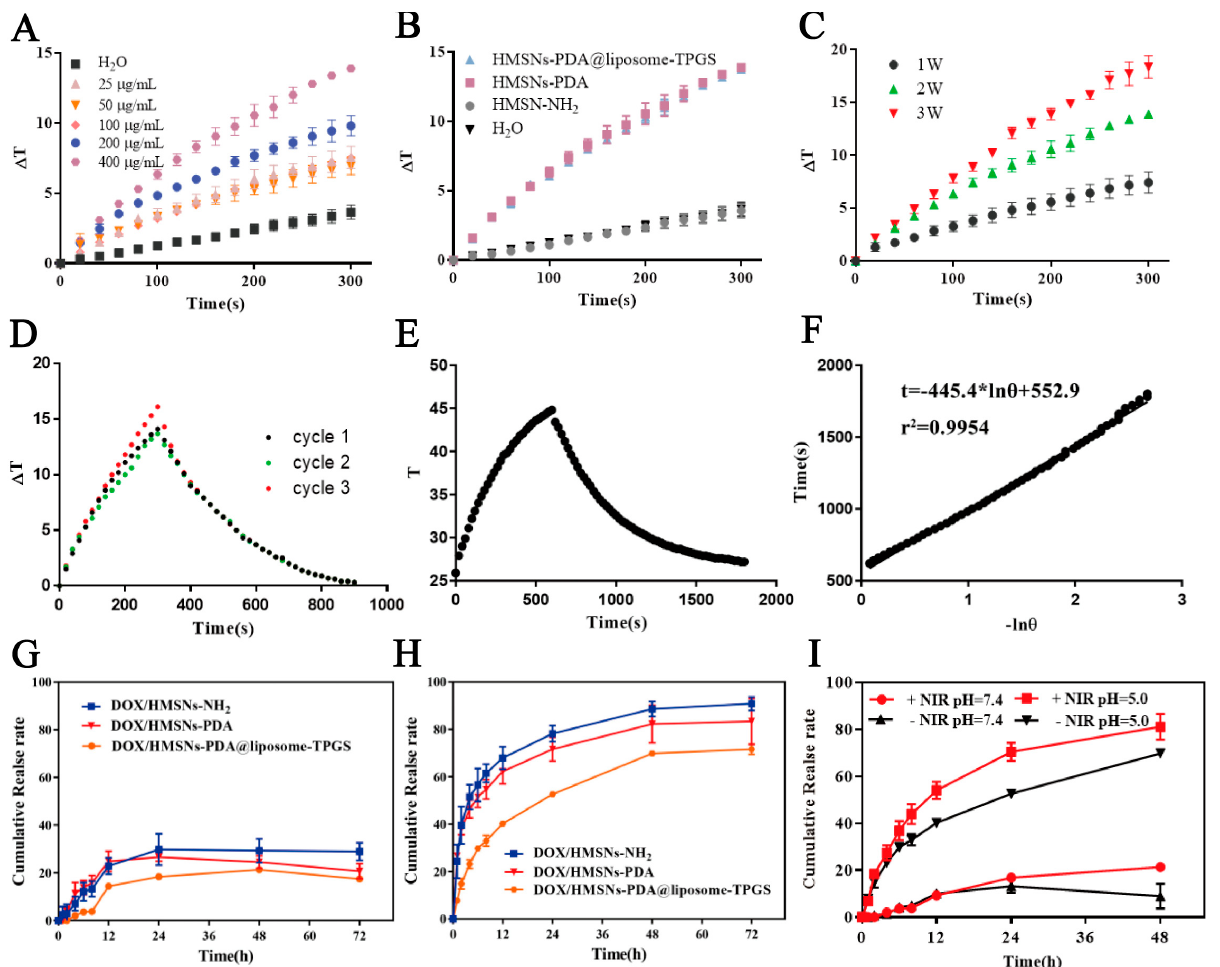
Figure 3. ( A ) Temperature change curves of HMSNs-PDA@liposome-TPGS aqueous solution with different concentrations upon NIR laser irradiation (2 W/cm 2 , 5 min). ( B ) Temperature change curves of HMSNs-PDA@liposome-TPGS, HMSNs-PDA, HMSNs-NH 2 , and water. ( C ) Time–temperature curves of HMSNs-PDA@liposome-TPGS aqueous solution with various laser power densities (concentration: 400 μ g/mL). ( D ) Thermal stability of HMSNs-PDA@liposome-TPGS under NIR laser irradiation (2 W/cm 2 ) for three laser on/off cycles. ( E ) Temperature variation curve of HMSNs-PDA@liposome-TPGS aqueous dispersion under 808 nm laser irradiation (2 W/cm 2 ). ( F ) The liner plot of the cooling time (t) versus negative natural logarithm of the temperature driving force ( − ln( θ )). Drug cumulative release curves of di ff erent samples at pH 7.4 ( G ) and pH 5.0 ( H ). ( I ) DOX release profiles from HMSNs-PDA@liposome-TPGS at different pH values without and with NIR laser irradiation.